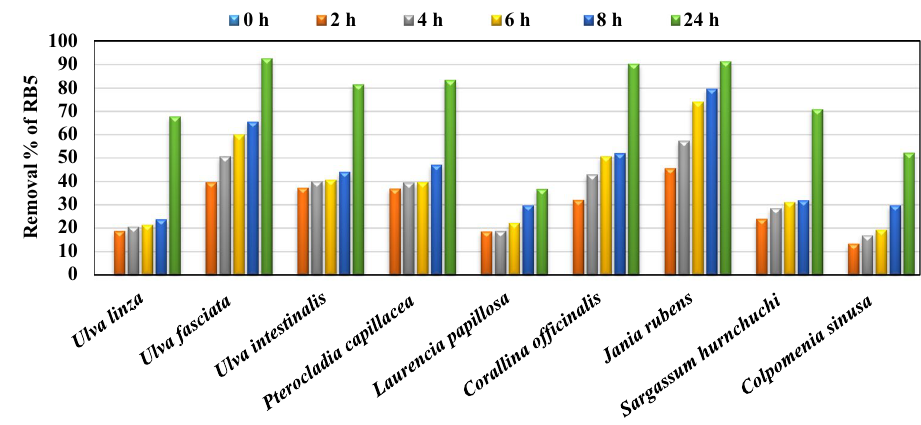
Fig. 2 Removal percentage of Reactive Black 5 by the nine studied fresh algal species